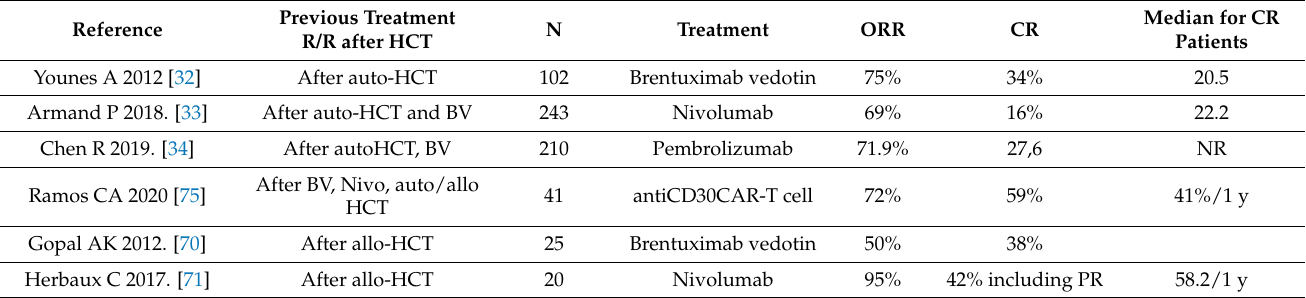
Table 6. Treatment of r/r HL recurring after stem-cell transplantation with brentuximab vedotin, nivolumab, pem- brolizumab, and CAR-T